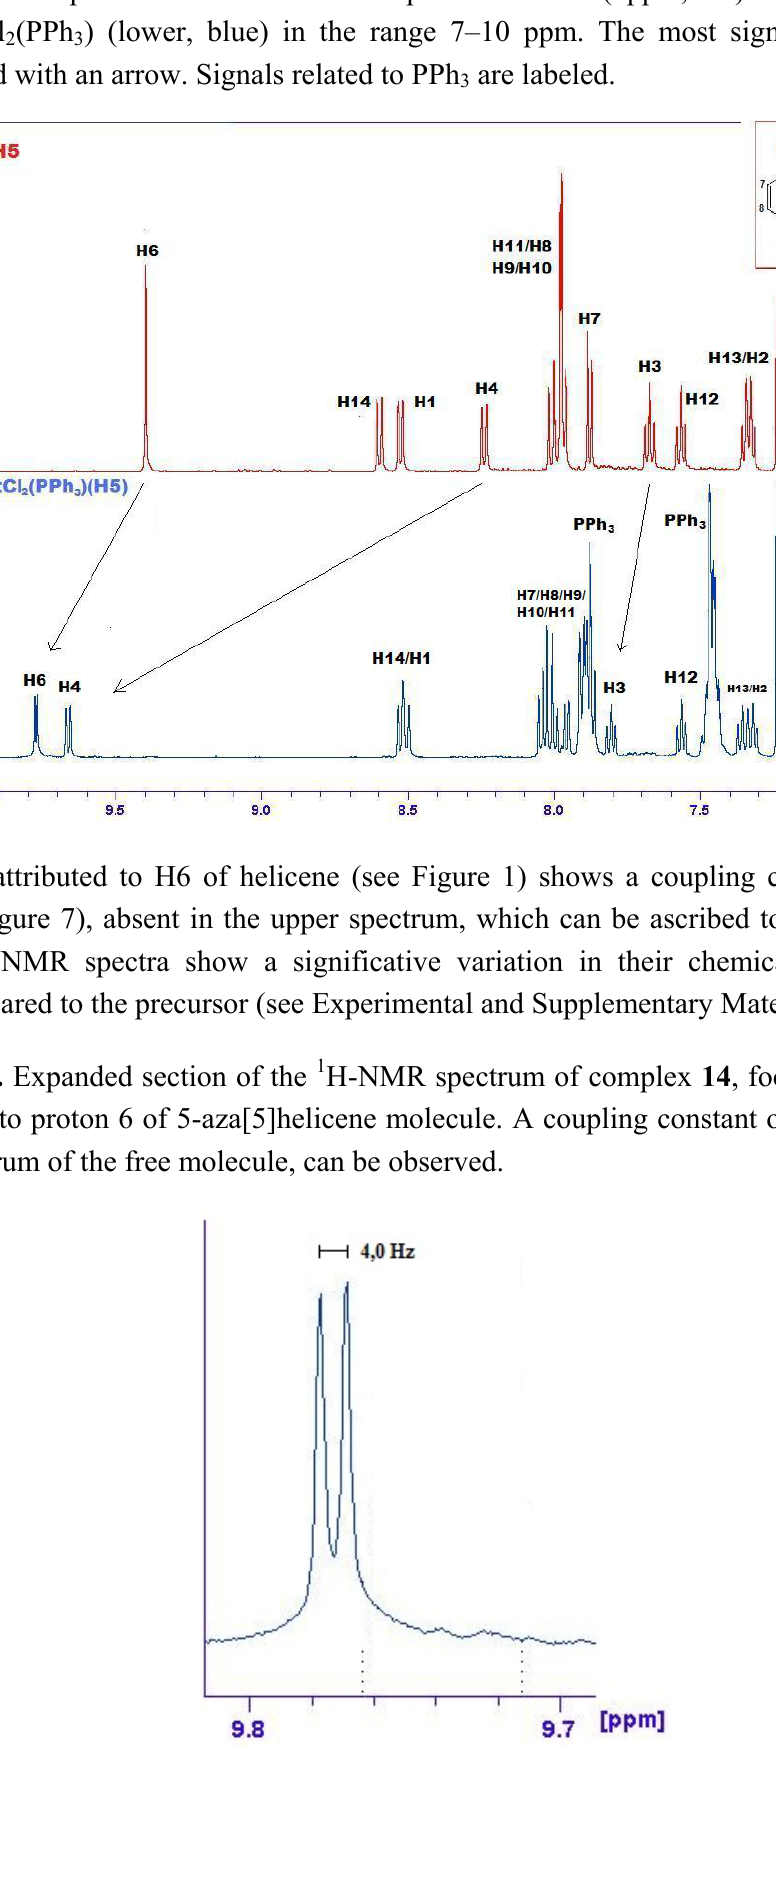
Figure 6. Comparison between 1 H-NMR spectra of free 5 (upper, red) and its complex 14 with PtCl (PPh ) (lower, blue) in the range 7–10 ppm. The most significant shifts are 2 3 evidenced with an arrow. Signals related to PPh